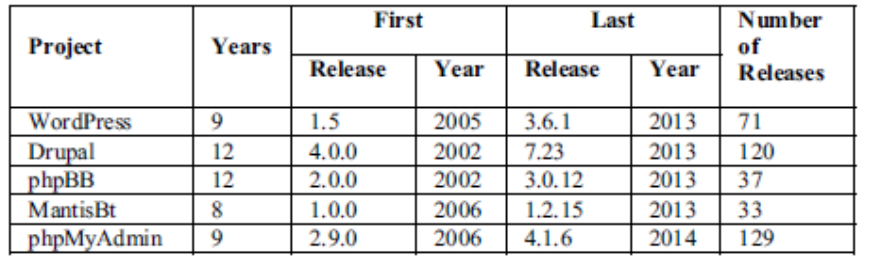
Fig. 1. Release Statistic for the Examined